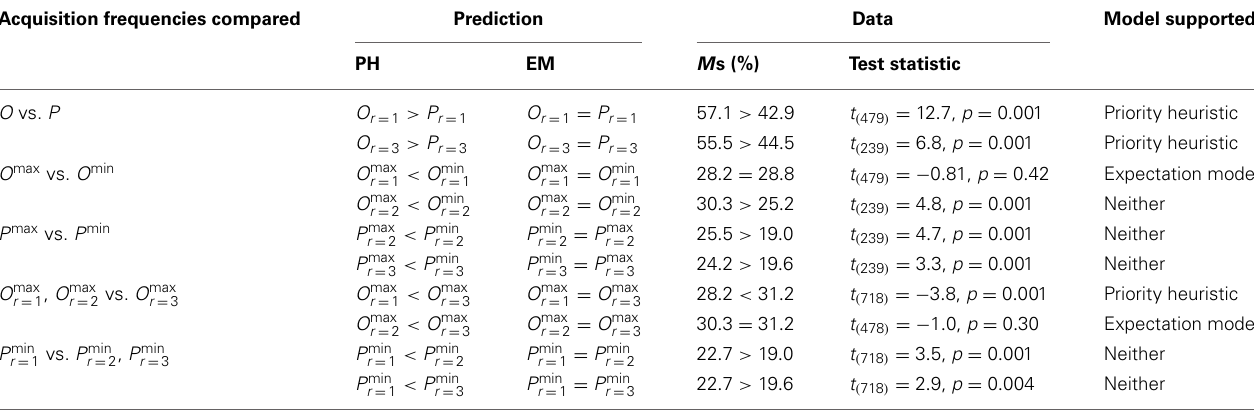
Table 1 | Tests of the relative acquisition frequencies predicted by the Priority Heuristic (PH) and modifications of expected utility theory (Expectation Model; EM) in Experiment